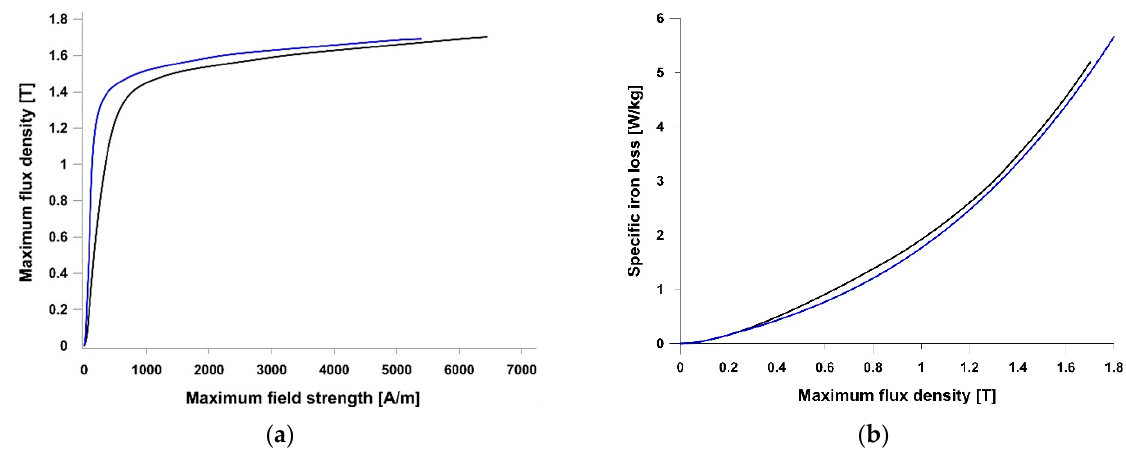
Figure 3. The measured at 50 Hz, B-H curves ( a ) and specific iron loss ( b ) for M470-50A material. Black curve—for partially damaged material, blue one—for undamaged material.